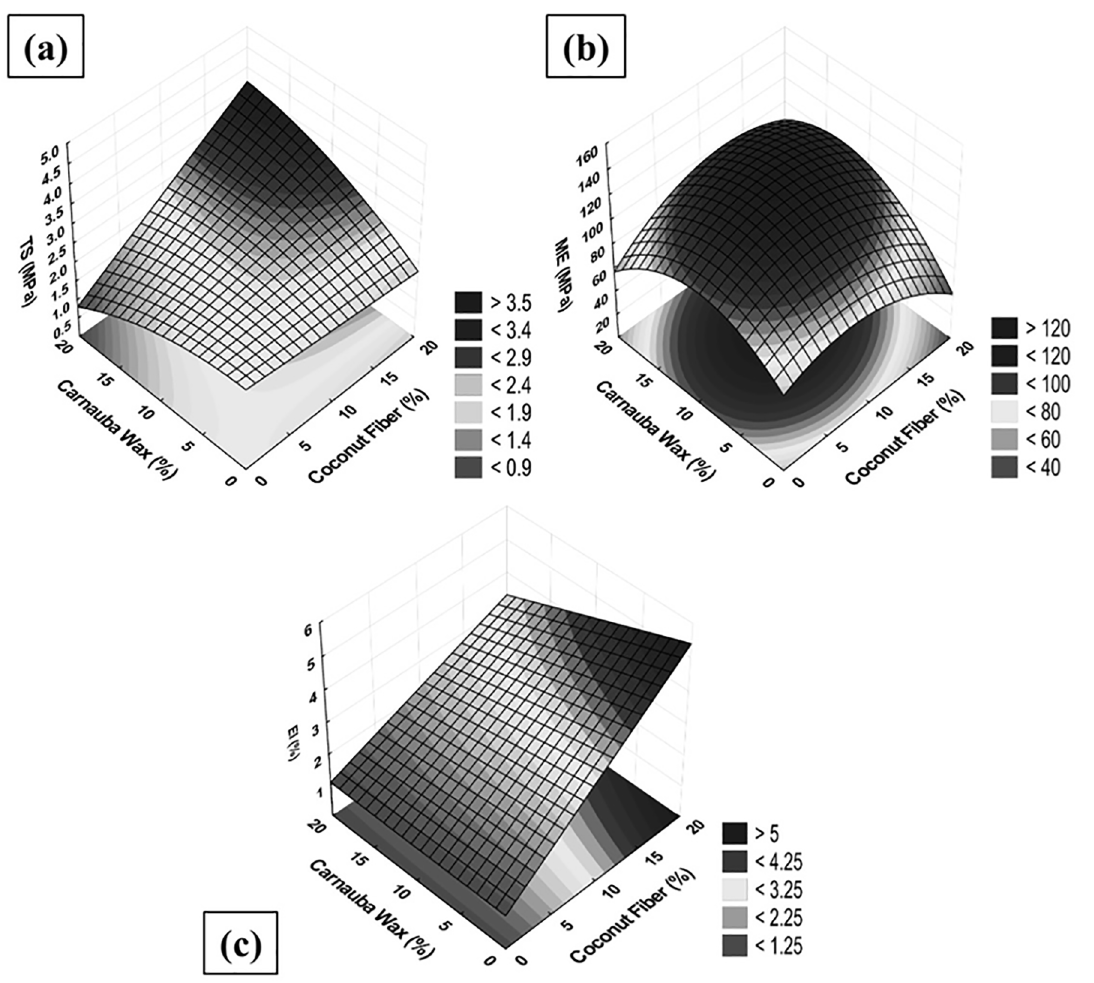
Figure 3. Response surfaces for (a) tensile strength (TS), (b) modulus of elasticity (ME) and (c) elongation at break (El) of biocomposites as a function of coconut fiber and carnauba wax